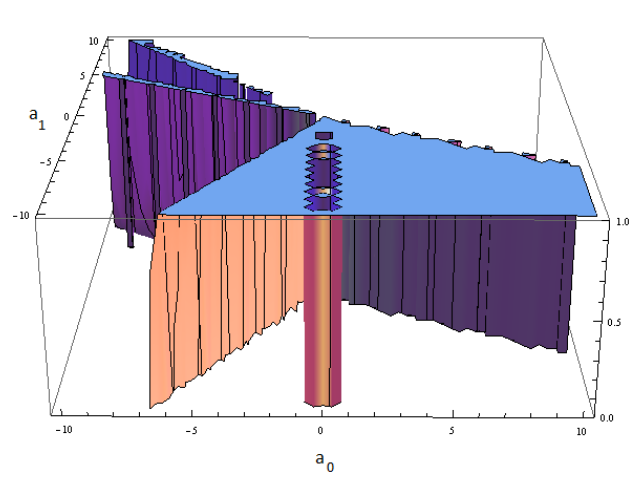
Figure 2. Stability region of ex 1 ( a 0 , a 1 ) .